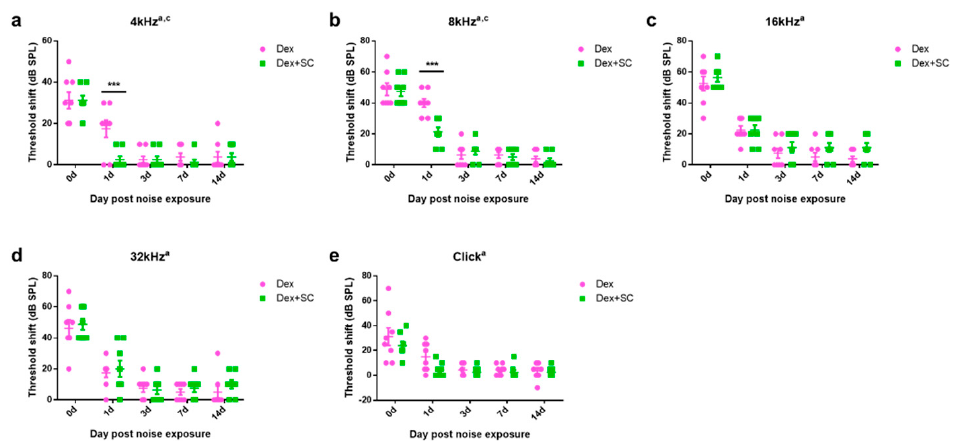
Figure 5. Sodium caprate co-treatment hastens recovery from noise trauma. ( a , b ) At 4 and 8 kHz, SC co-treatment significantly hastened recovery at 1 d post-noise trauma as compared to the dex-only group. ( c – e ) No significant differences were found from other frequencies and click. Graphs represent mean ± SEM. Two-way repeated measures ANOVA; Sidak’s multiple comparisons test; a, main effect of treatment; c, main effect of interaction; *** p < 0.001.